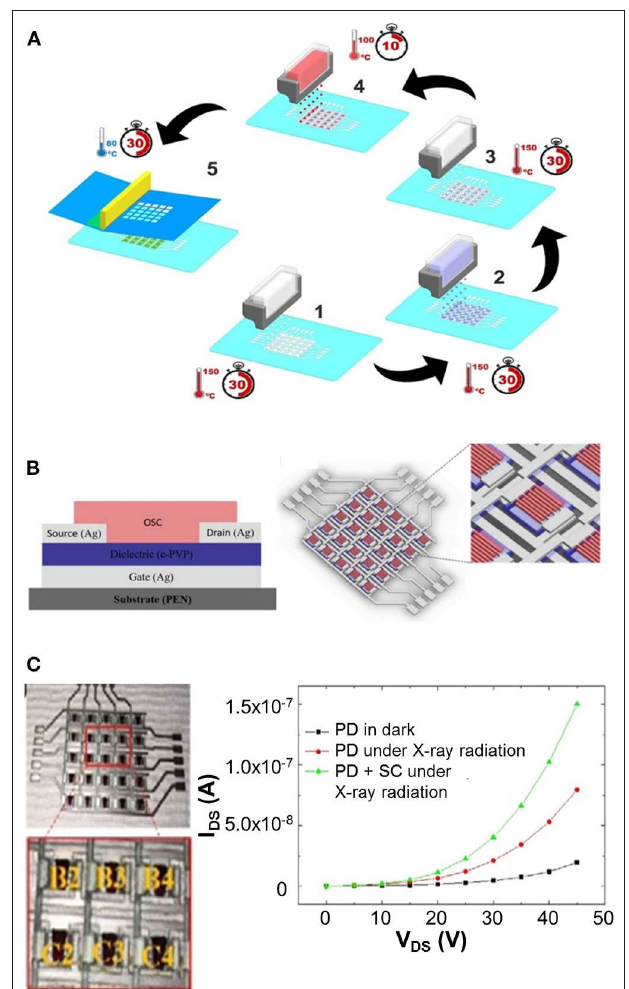
FIGURE 8 | (A) A schematic representation of the printing procedure for preparing multilayer radiation sensors composed of (1) a Ag electrode, (2) a dielectric layer (PVP), (3) Ag source and drain electrodes, (4) a semiconducting polymer layer, and (5) a scintillator ink. (B) A schematic image of the layer structure for both the individual radiation sensors and a 5 × 5 array prepared for imaging. (C) Photographs of the devices and I – V curves of one of the single photodiodes (PDs) present in the array in dark (black curve) and under X-ray radiation with (green curve) and without (red curve) the scintillator (SC) film. Reproduced with permission from Oliveira et al. [113]. Copyright 2018 by the American Chemical